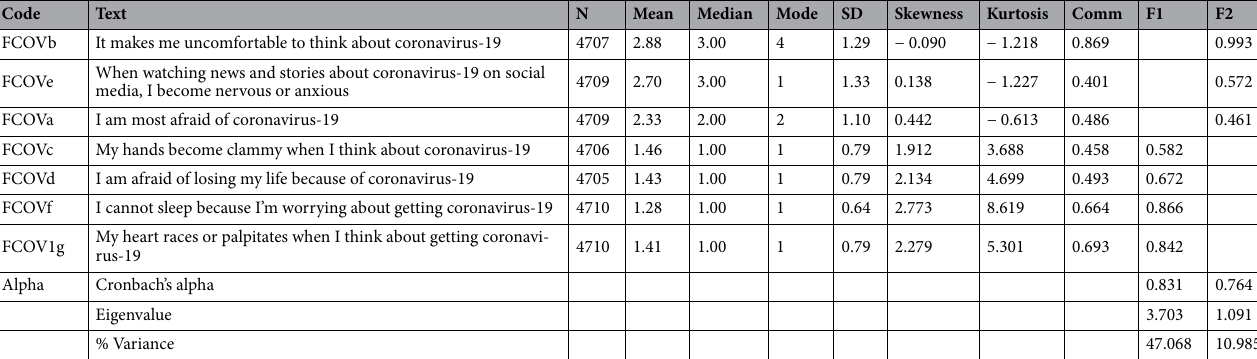
Table 4. Measures of central tendencies and results of Principal Component Analysis of the Slovenian version of the Fear of COVID-19 scale. Items are ordered by decreasing mean. SD standard deviation, Comm. Communalities. F1 Component loadings of the first principal component. F1 Component loadings of the second principal component.